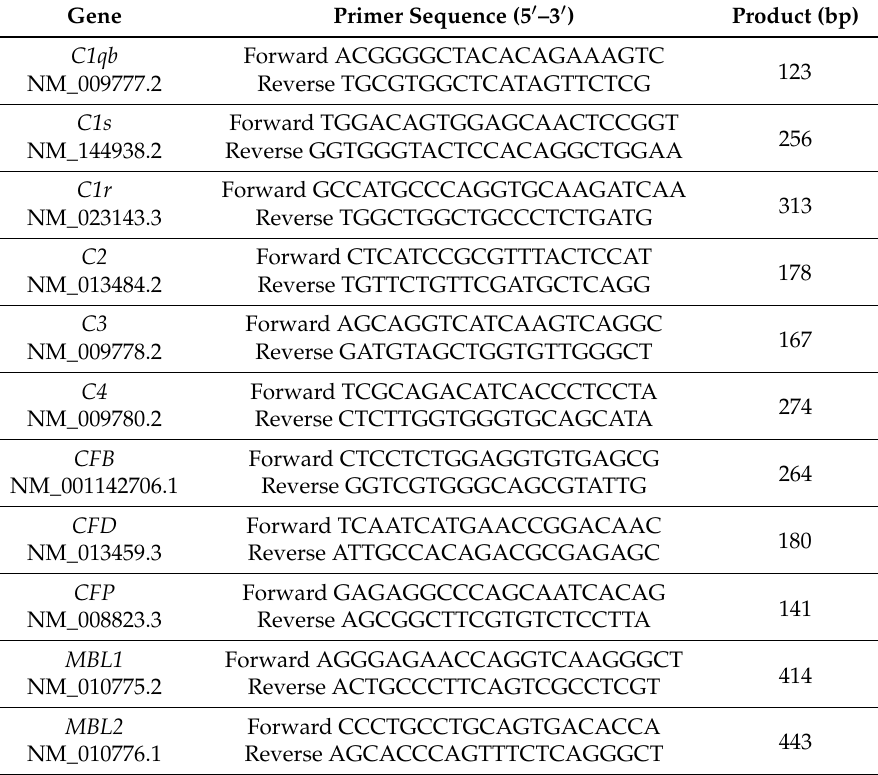
Table 3. List of primers used in conventional PCR